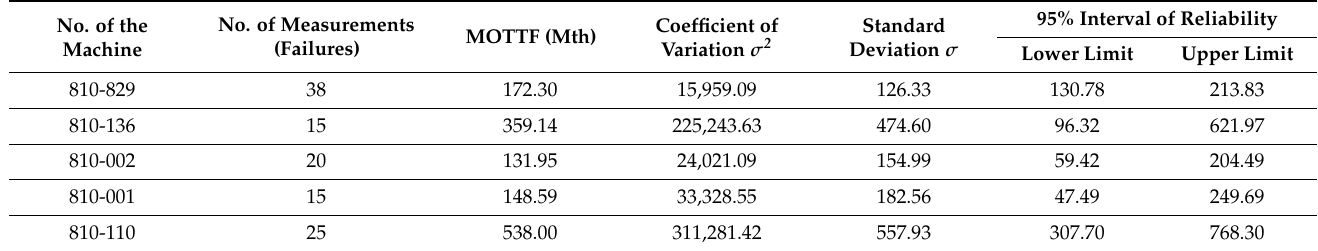
Table 3. Basic details of the statistical characteristics for all forwarders.